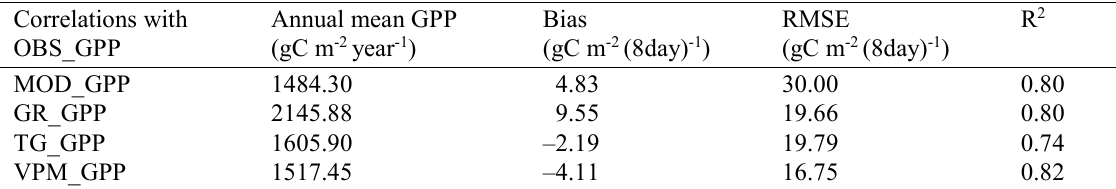
Table 2 Bias, root mean square error (RMSE), and coefficients of determination (R 2 ) between MOD_GPP / GR_GPP / TG_GPP / VPM_GPP and OBS_GPP in Yucheng site from 2003 to 2005. Correlations